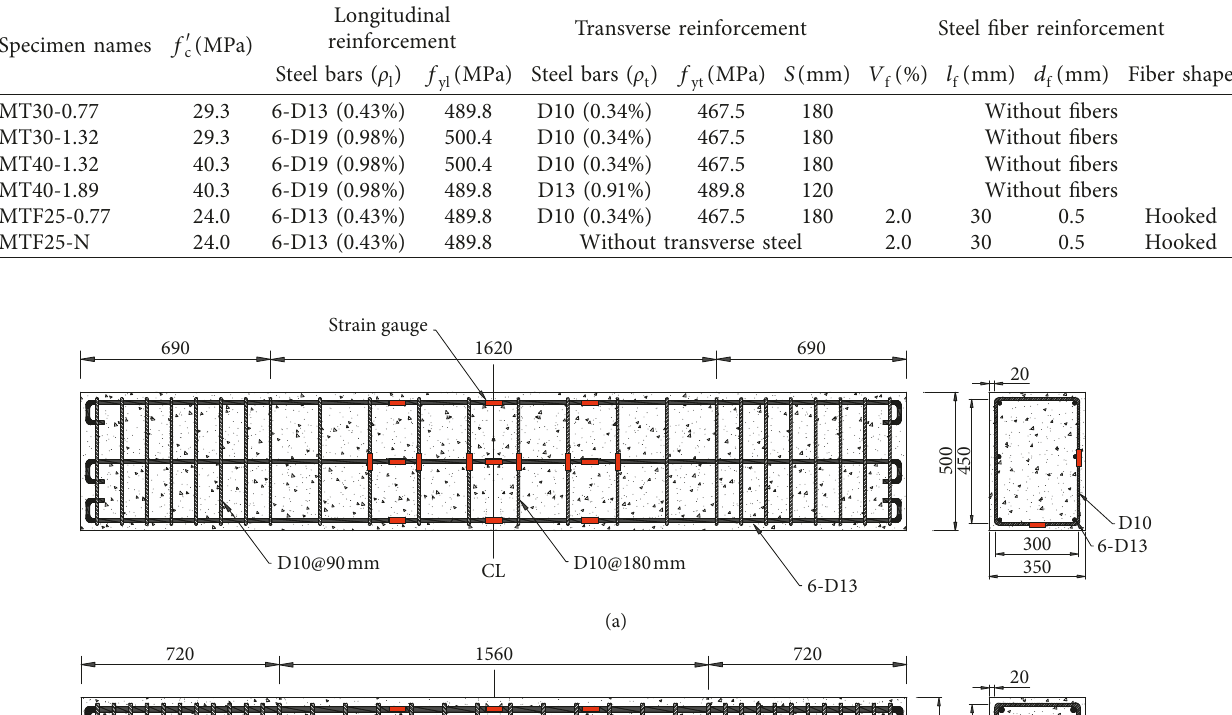
Table 1: Details and properties of specimens.